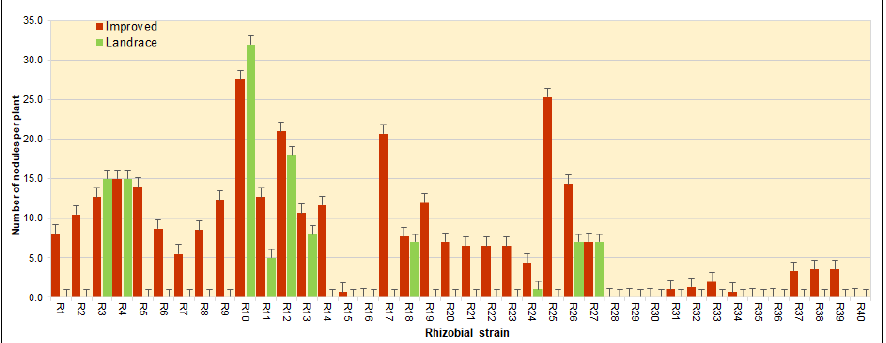
Figure 2. The effects of inoculation with rhizobial strains on the number of nodules per plant of the landrace and improved pigeonpea genotypes. The identity of each rhizobial strain (R1–R40) is described in Table 2 and the results of the statistical analysis are reported in Tables S1 and S2 (depending on the